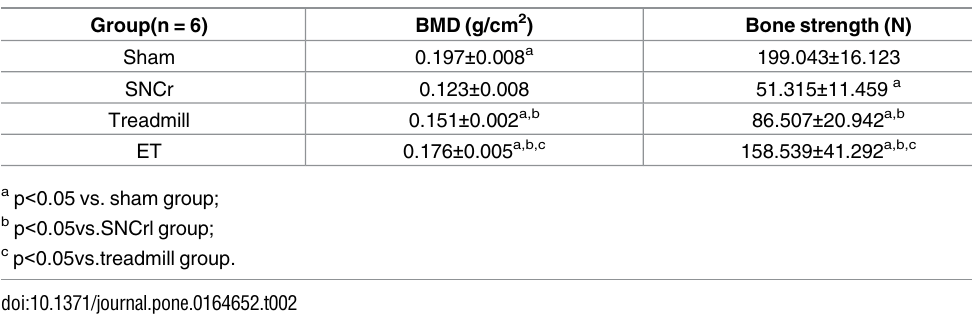
Table 2. Comparison of BMD, bone strength and SP 4weekspost